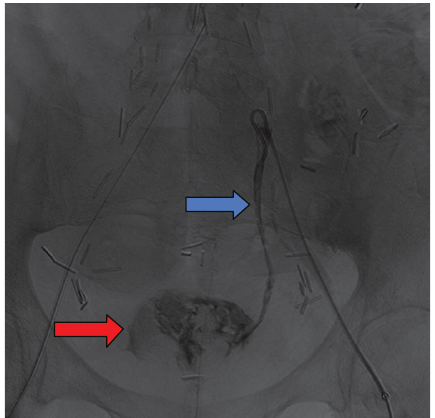
Figure 1: Left ureteral retrograde pyelogram demonstrates contrast opacification of the left external iliac artery (solid blue arrow) consistent with left ureteral-arterial fistula. Scattered surgical clips are present throughout the pelvis.